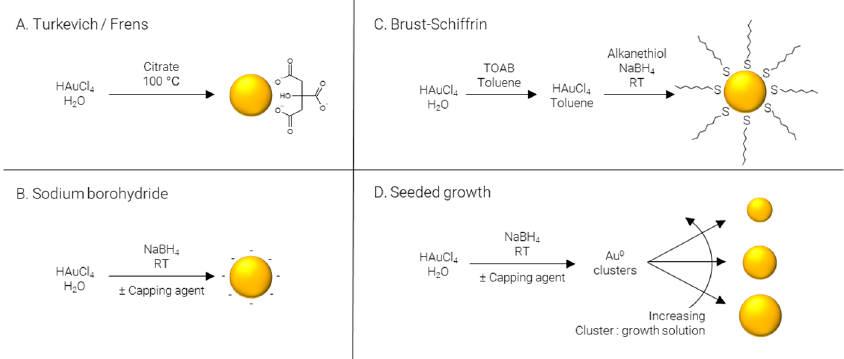
Figure 3. Methods of AuNP synthesis.